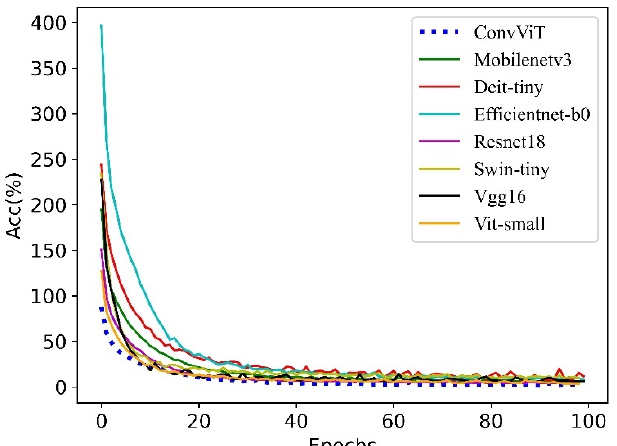
Figure 10. Loss comparison with the state-of-the-art methods.